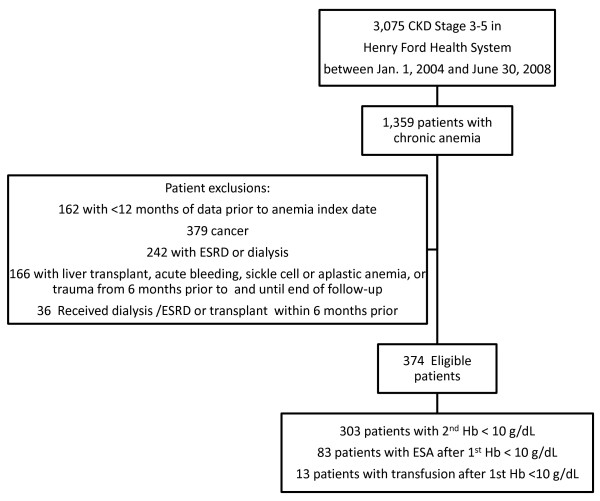
Non-dialysis CKD patients with persistent anemia: inclusion and exclusion chart.